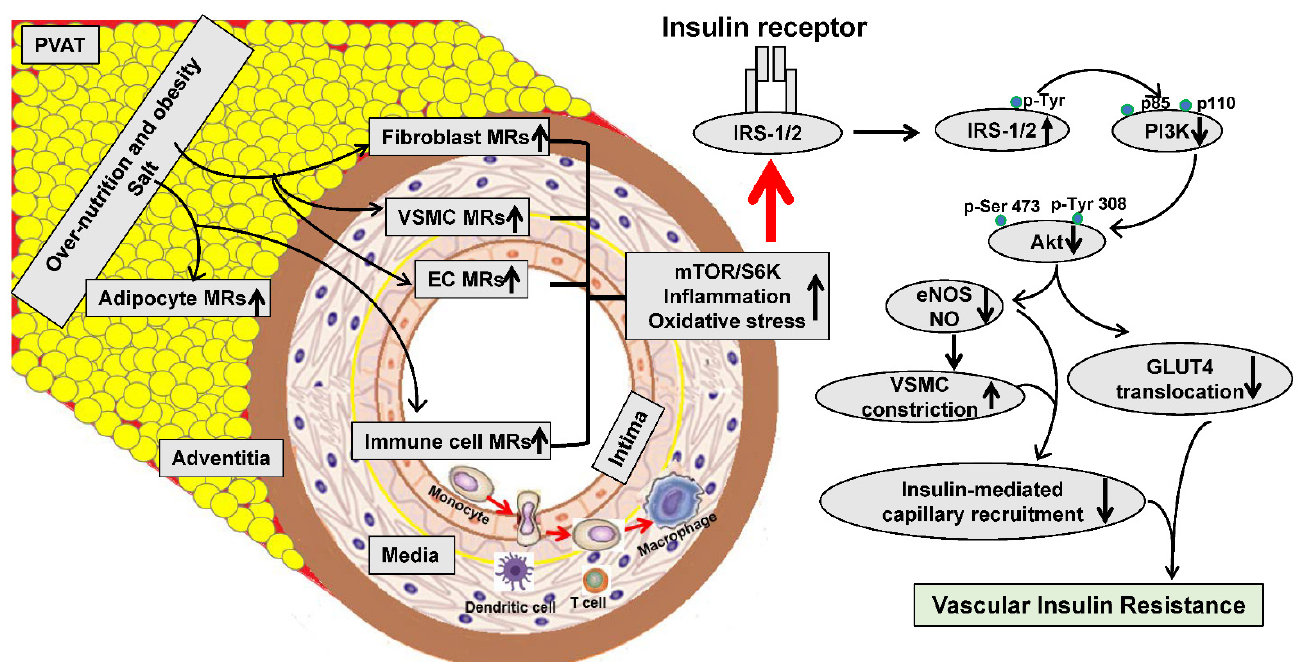
Figure 2. Proposed mechanisms for the inappropriate mineralocorticoid receptor activation in the pathogenesis of vascular insulin resistance. Arrow represents a process in vascular insulin resistance. MR: Mineralocorticoid receptor; PVAT: Perivascular adipose tissue; EC: Endothelial cell; VSMC: Vascular smooth muscle cell; mTOR: Rapamycin (mTOR); S6K1: Ribosomal S6 kinase; IRS-1: Insulin receptor substrate 1; PI3K: Phosphoinositide 3-kinases; Akt: Protein kinase B; GLUT4: Glucose transporter 4; NO: Nitric oxide; eNOS: Endothelial NO synthase.